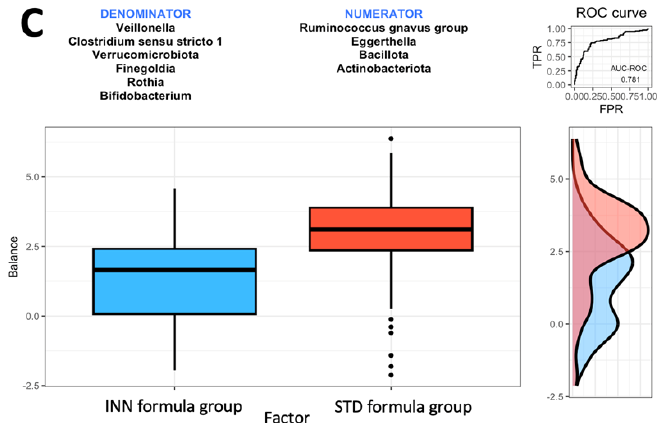
Figure 1. Group balances are presented in an overview. It is indicated at the top of the plot that two groups of taxa constitute the global balance. Box plots illustrate the distribution of balance scores for INN and BF groups ( A ), STD and BF groups ( B ), and INN and STD groups ( C ). On the right, the ROC curve with its AUC value and the density curve are displayed.